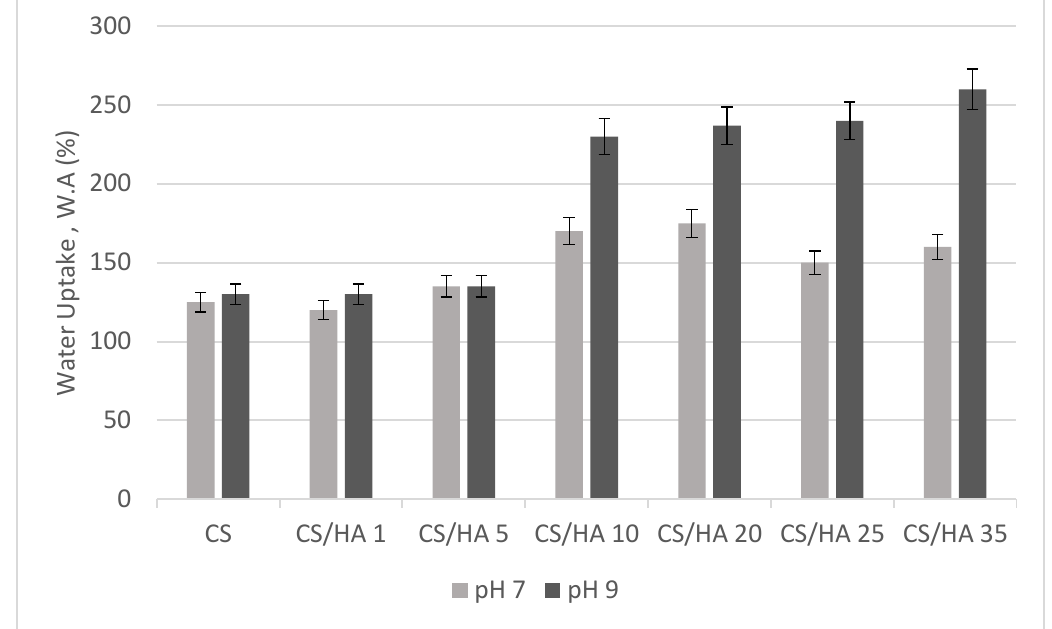
Figure 5. Equilibrium water uptake of CS and CS/HA matrices in PBS (pH 7) and Tris (pH 9) buffer.